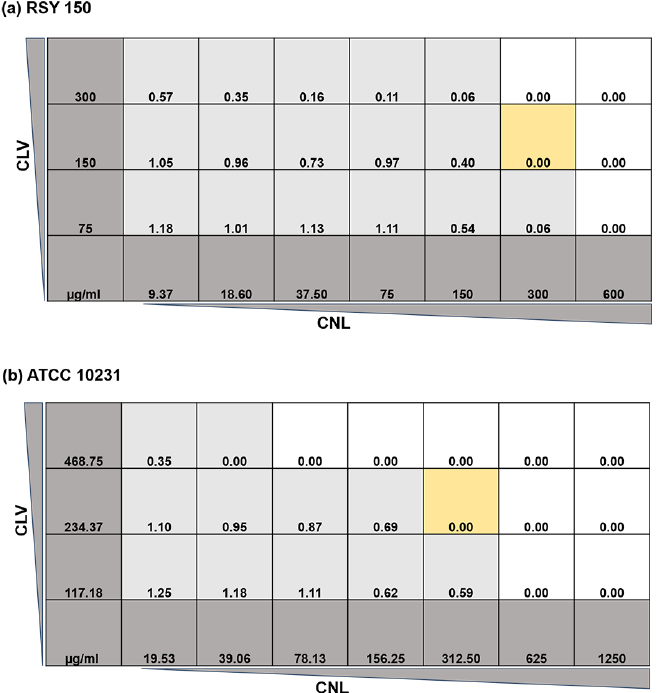
Figure 1. Checkerboard microtiter plate assay of C. albicans ( a ) RSY150 and ( b ) ATCC10231. Dark grey is oil concentration, light grey is visible growth, white is no growth, and light brown highlights the lowest combined lethal concentration (LCLC) having zero growth (OD 600 ).